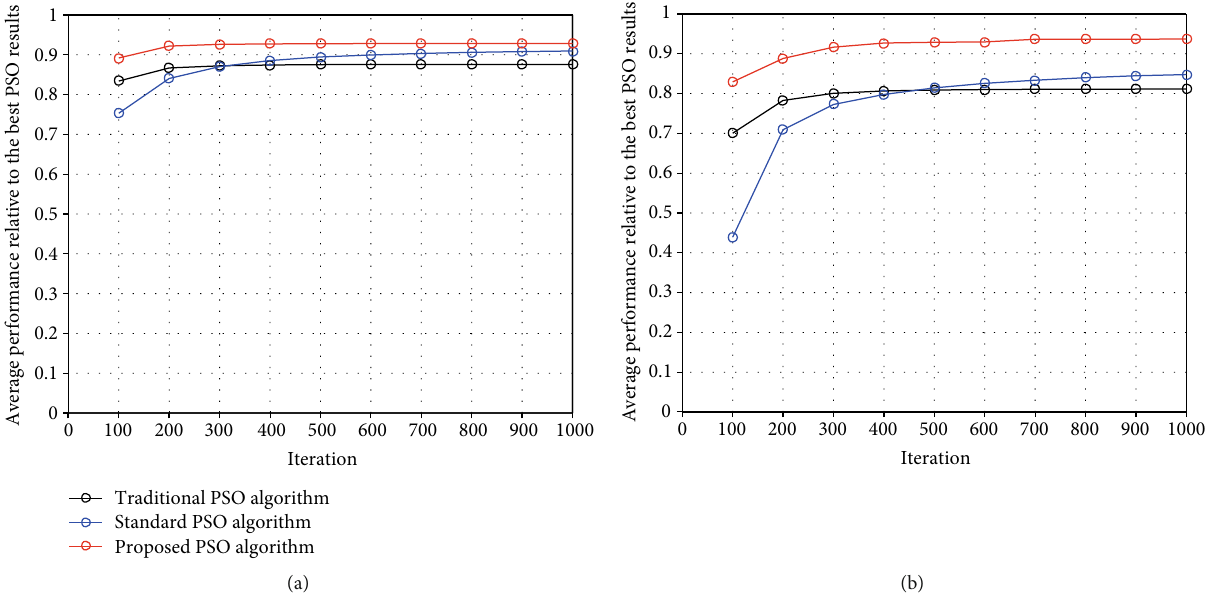
Figure 16: Average performance comparison for preprocessing steps according to the number of iterations for the short-range test cases (a) and the long-range test cases (b). Preprocessing steps are applied, and postprocessing steps are not applied for all 3 PSO